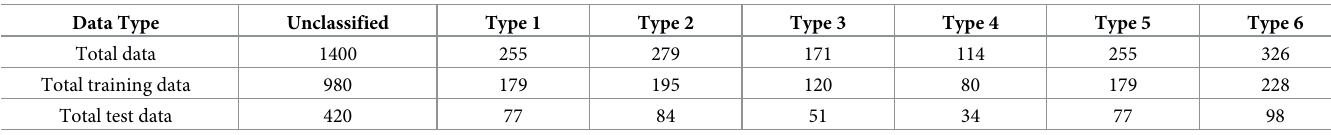
Table 2. Weaving behavior data allocation for the different